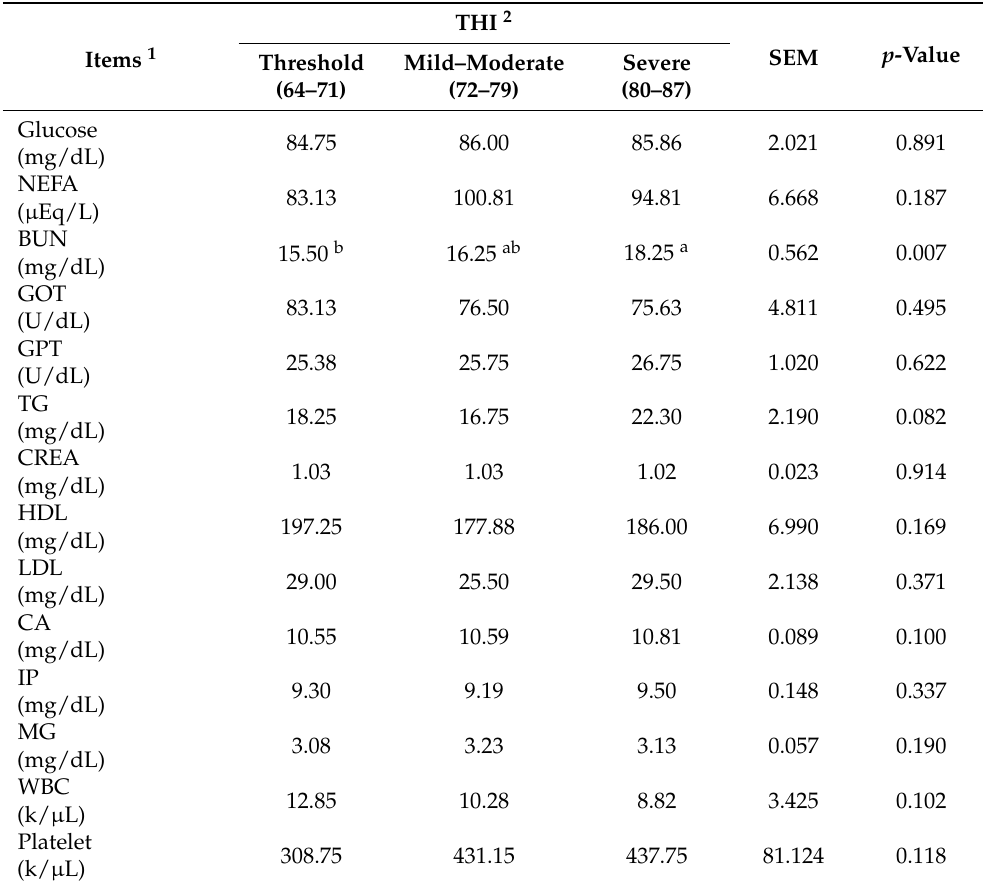
Table 4. Effect of heat stress level on blood metabolites and hematological parameters in Korean native beef